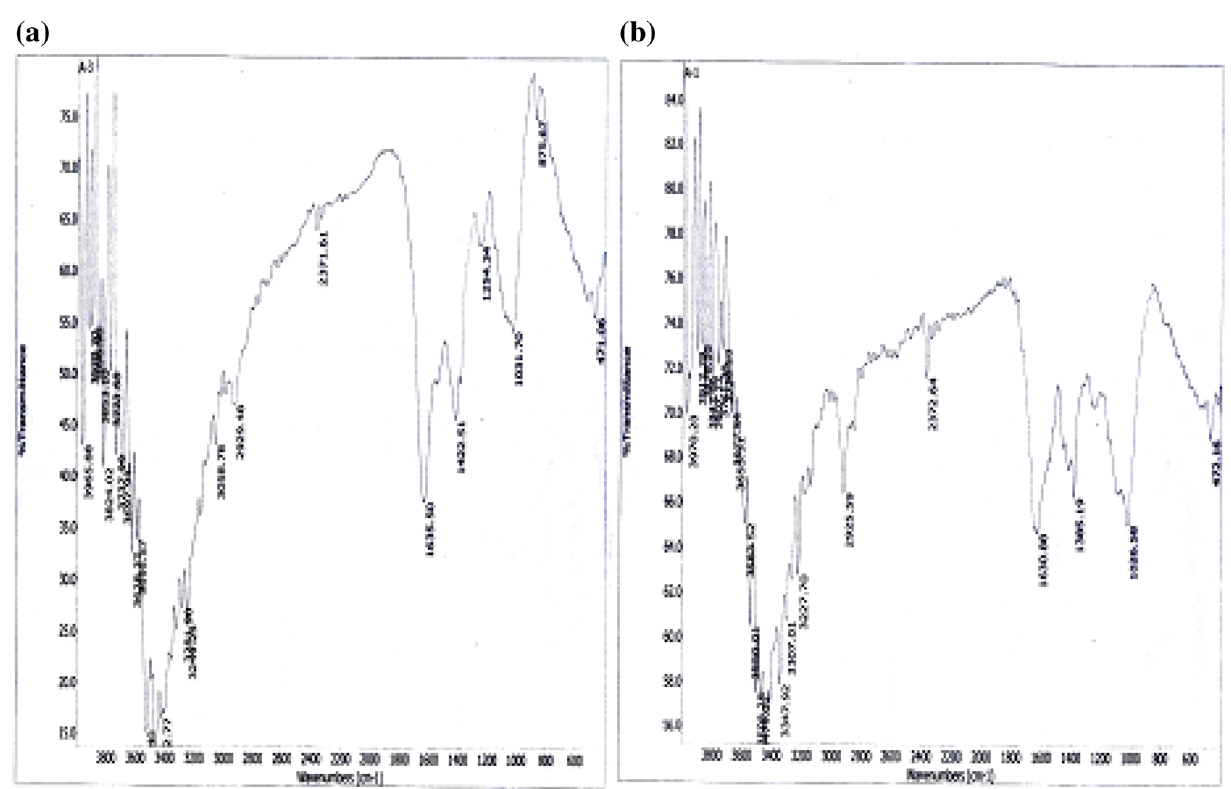
Fig. 1 a , b FT-IR spectrum of natural and treated